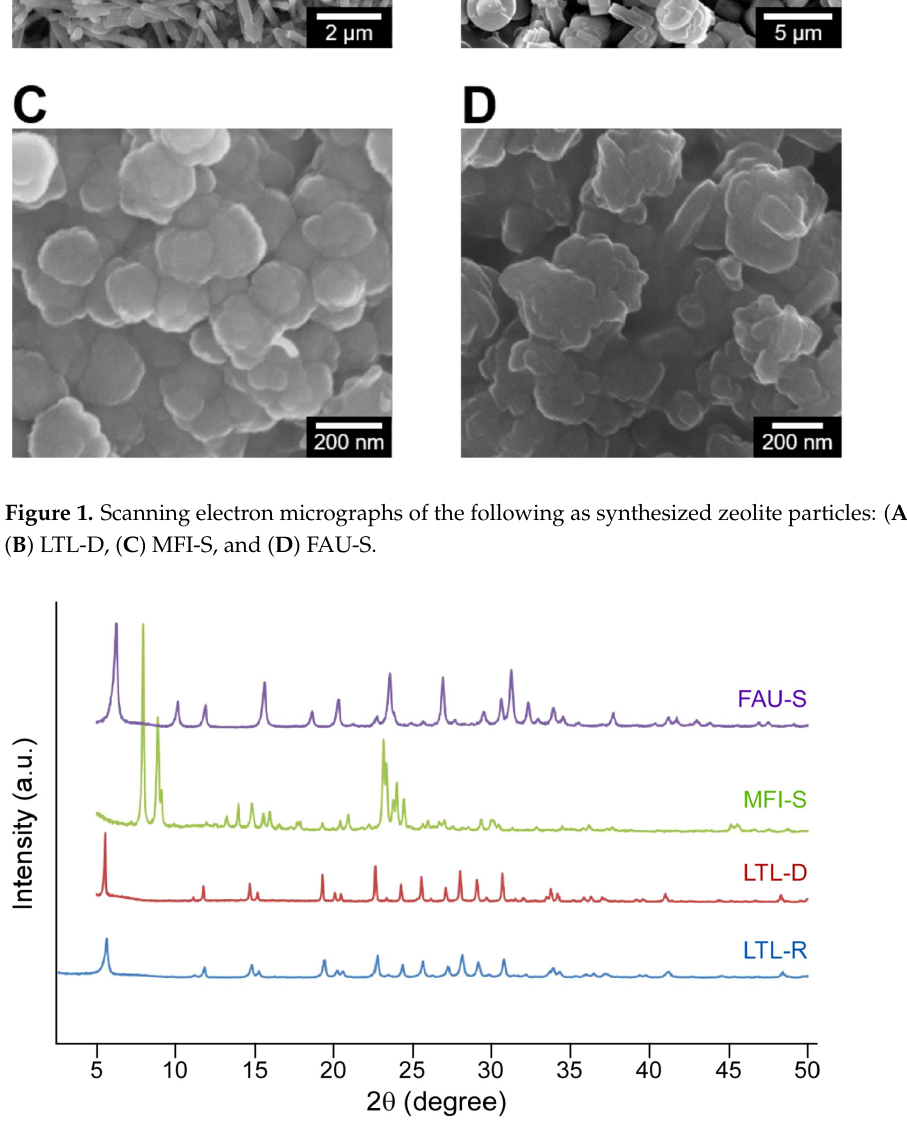
Figure 2. Powder X-ray diffraction patterns of the following as synthesized zeolite samples: FAU-S (purple), MFI-S (green), LTL-D (red), and LTL-R (blue). The patterns are arbitrarily offset along the y-axis for visual